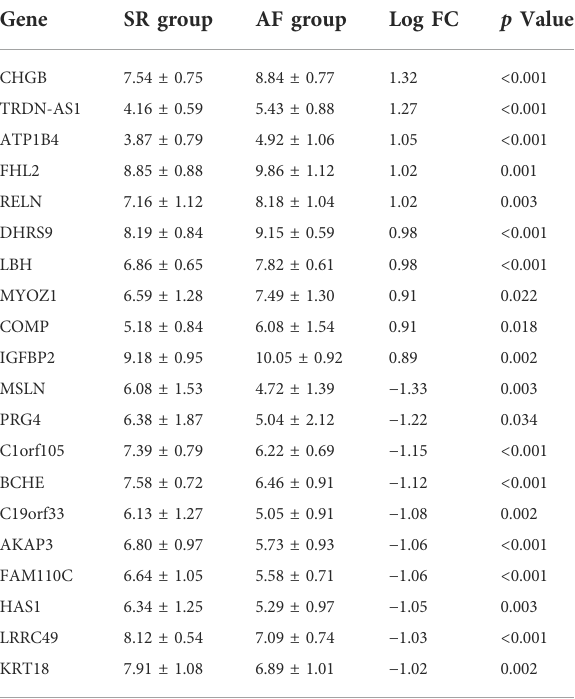
TABLE 1 The expression levels of top 20 DEGs between SR and AF